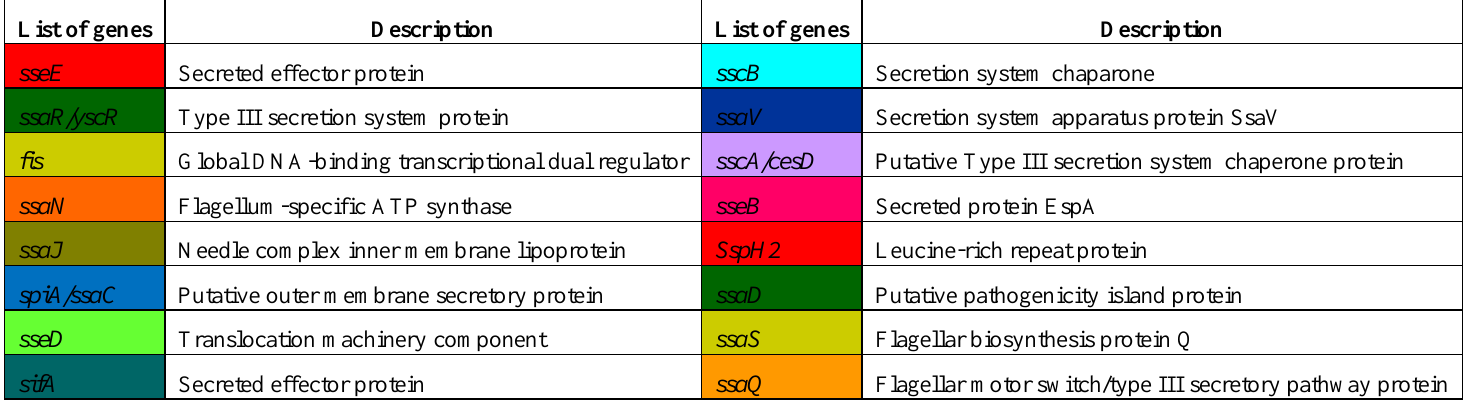
Table 8: Description for the genes in Figure 12b. The colour of gene corresponds to the colour of the line in the gene expression graph in